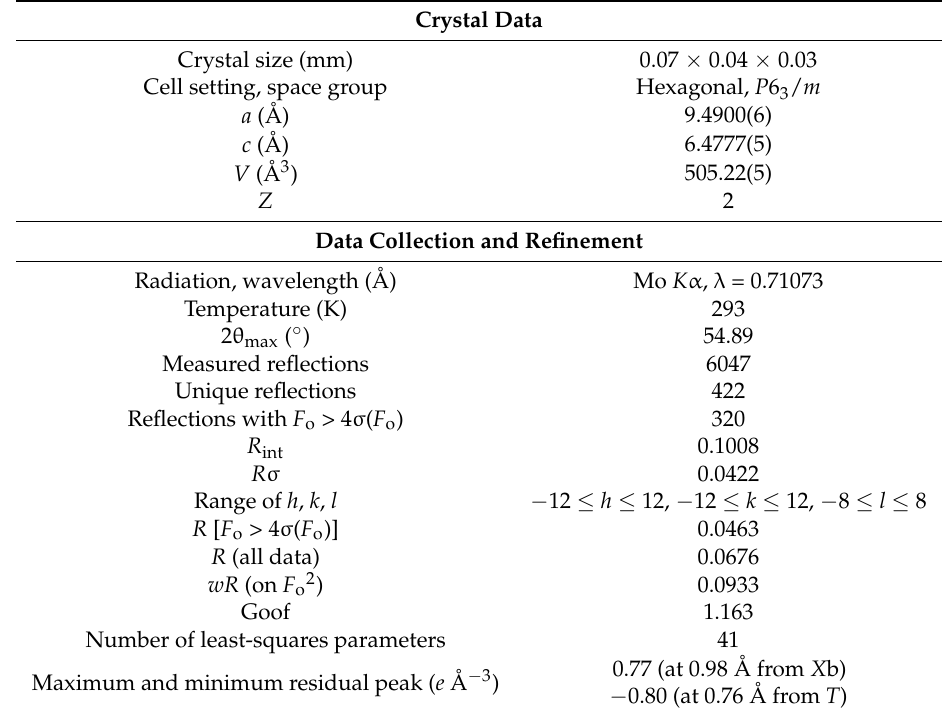
Table 2. Crystal and experimental details for parafiniukite.